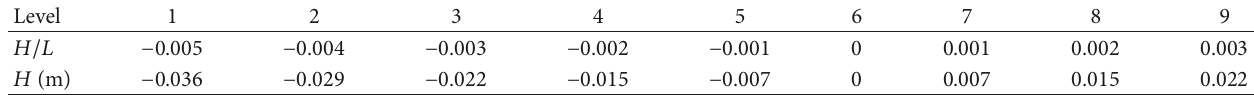
Table 4: Wave heights corresponding to different levels defined in Figure 7(a).